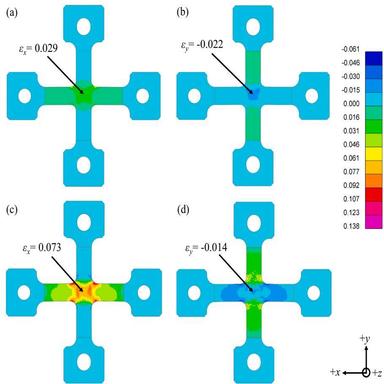
Predicted macro-strain in AA5182-O specimen during continuous strain path change: (a) εx and (b) εy strain distribution along uniaxial strain path before the strain path transition and (c) εx and (d) εy strain distribution after the strain path transition to biaxial strain path.